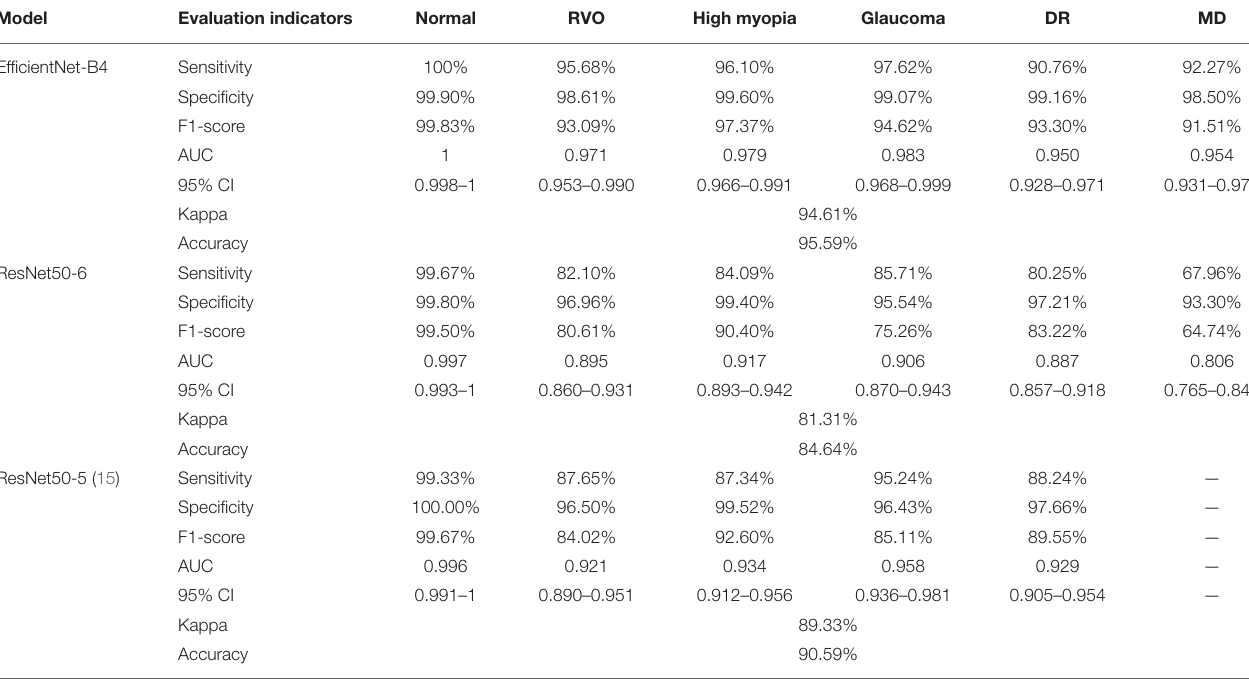
TABLE 3 | Evaluation of the index results of the three